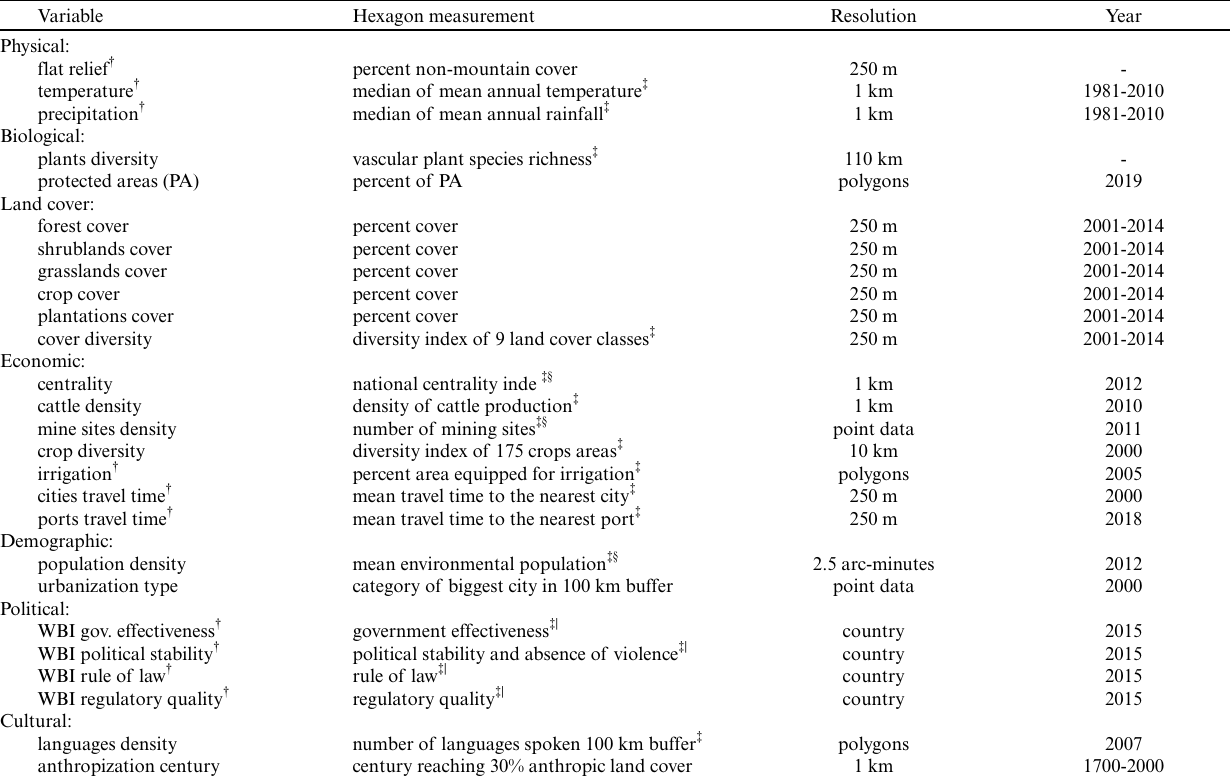
Table 1 . Compilation of input data. Note: WBI = World Bank